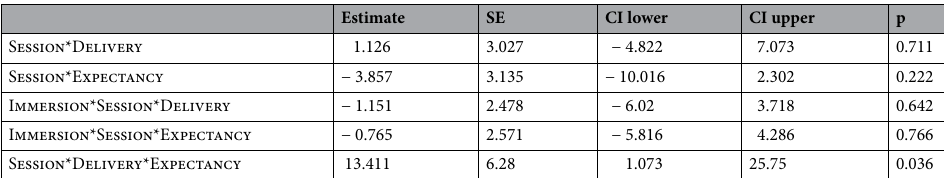
Table 2. Effects of immersion time and experimental conditions Delivery and Expectancy on continuous pain VAS ratings (hierarchical linear model). For brevity, only effects are displayed that a) included either one of the experimental conditions, and the session term, and b) are of lower or equal order than three-way interactions (higher order all n.s. p > 0.169). For the full model, see Supplementary Table S6. SE standard error, CI 95% confidence interval.